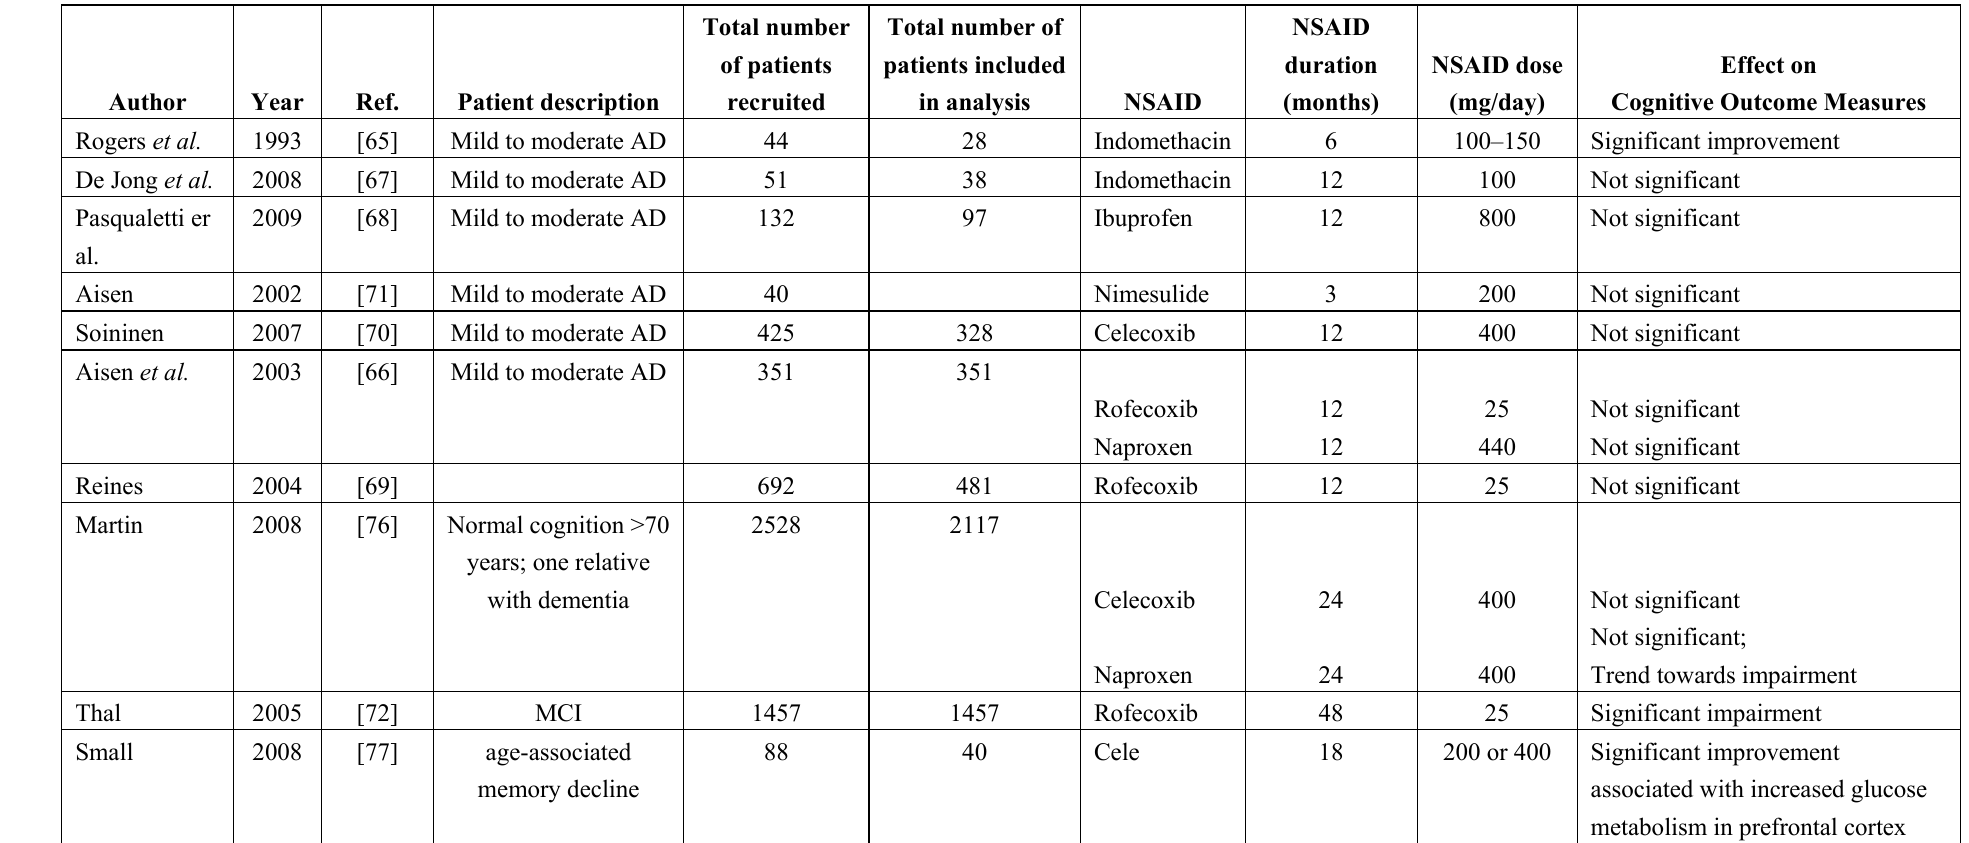
Table 2. Overview of clinical trials (double-blind, placebo-controlled) that investigated NSAID treatment on cognitive measures related to Alzheimer's disease and dementia. Modified from